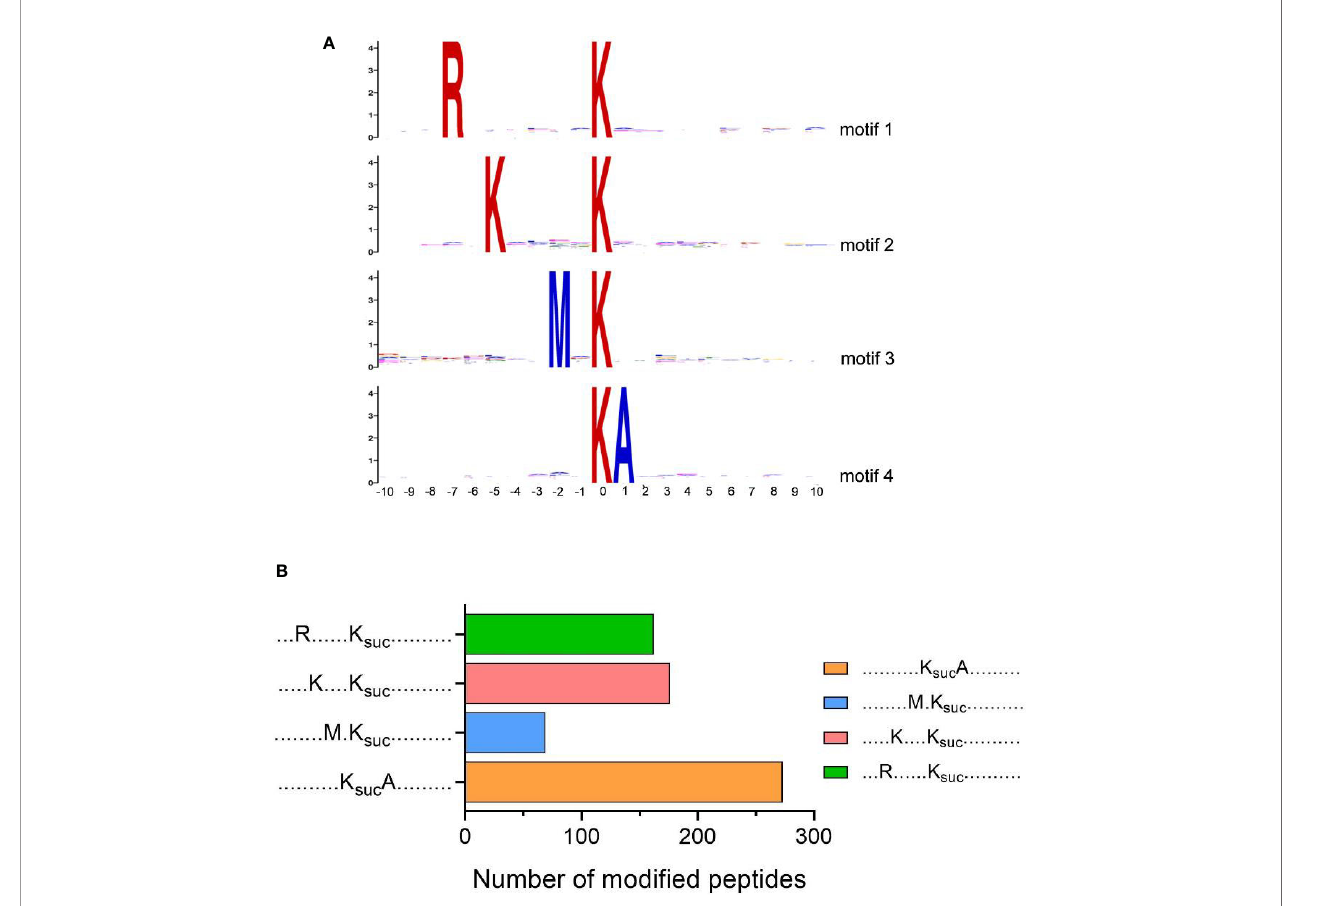
FIGURE 4 | Motif analysis of lysine succinylation sites. (A) Sequence logos of motifs ( P -value <0.000001) identi fi ed by MoMo software. (B) Numbers of each identi fi ed